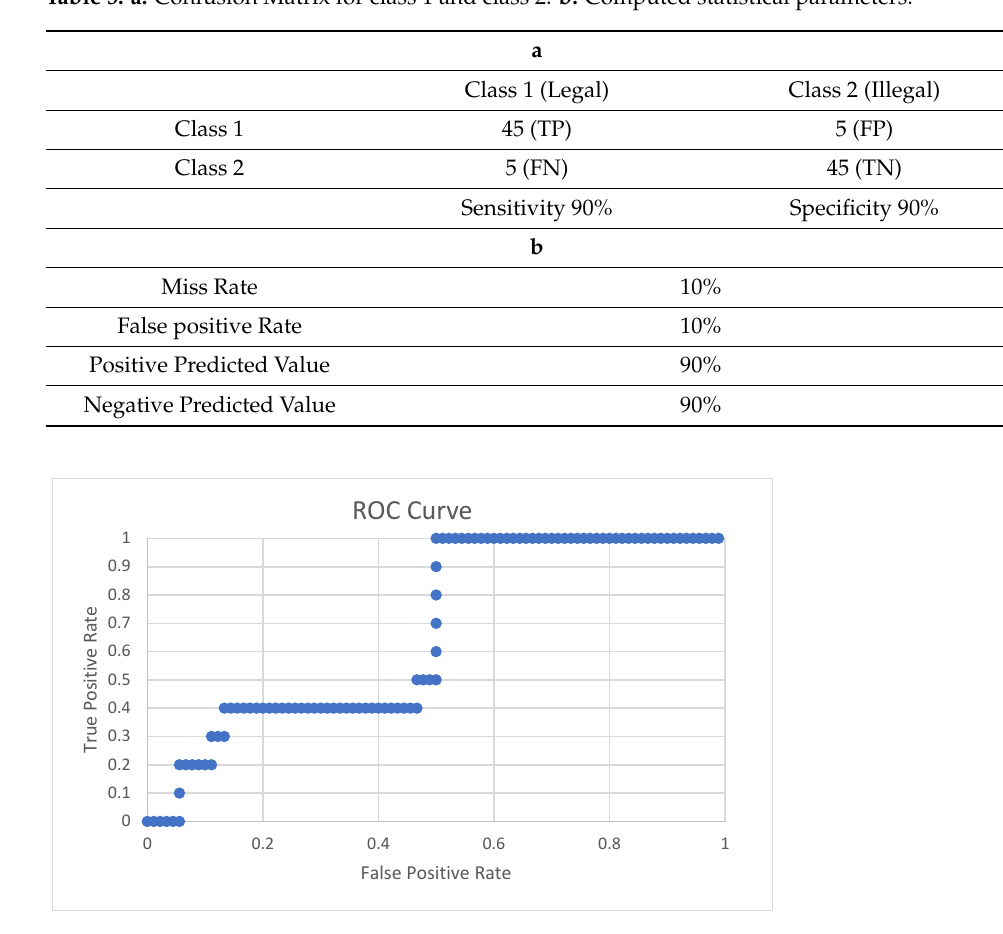
Table 5. a. Confusion Matrix for class 1 and class 2. b. Computed statistical parameters.